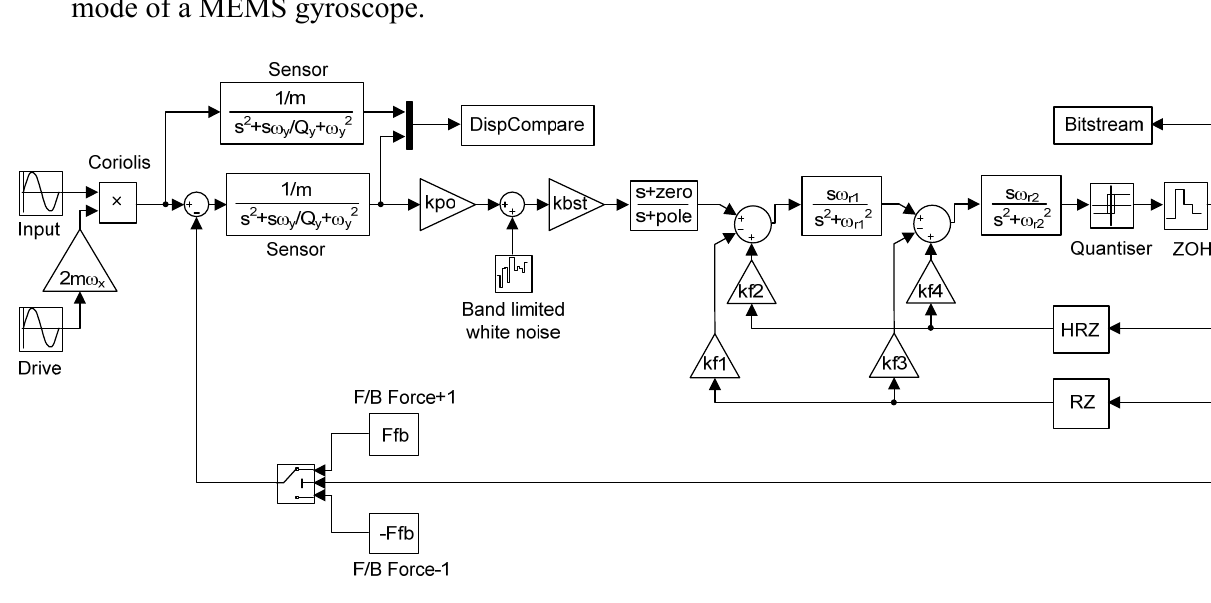
Figure 7. Simulink model of a six order continuous time, band-pass EM ΣΔ M for the sense mode of a MEMS